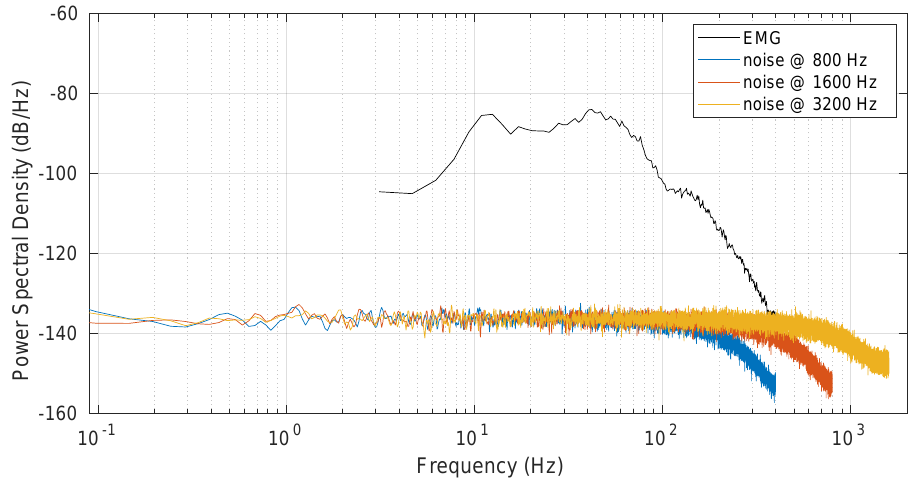
Figure 10. Noise floor, for different output data rates, compared with the power spectrum of a typical EMG signal recorded on the biceps